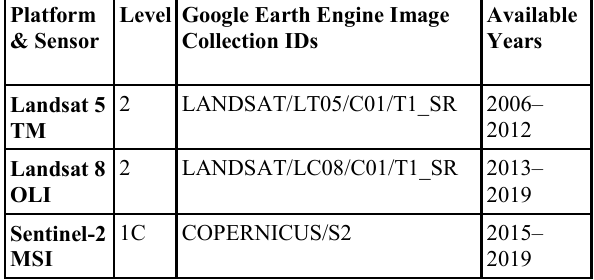
Table 1. Remote sensing products utilized in the development of